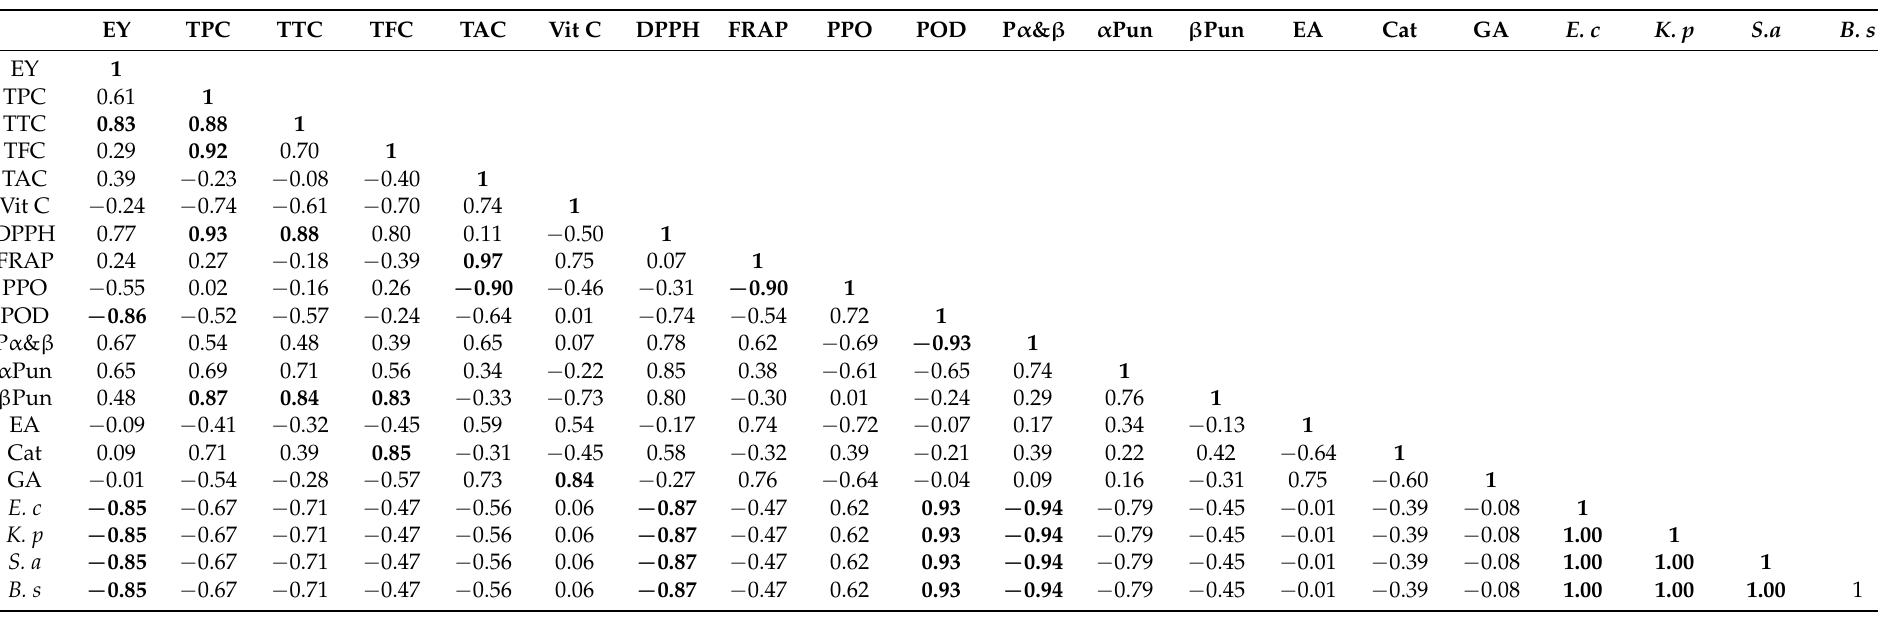
Table 4. Pearson’s correlation matrix between chemical indices measured from blanched (80 ◦ C for 3 min) ‘Wonderful’ pomegranate peel from three harvest